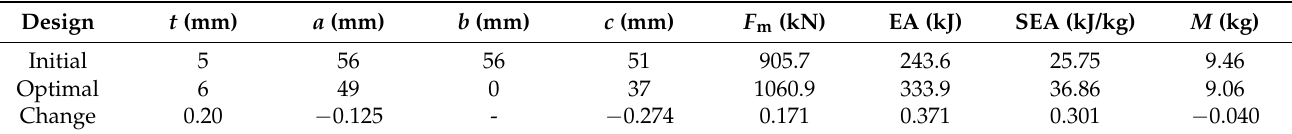
Figure 14. The force–displacement curves of two designs. Table 4. Comparison of the optimum design and the initial design.